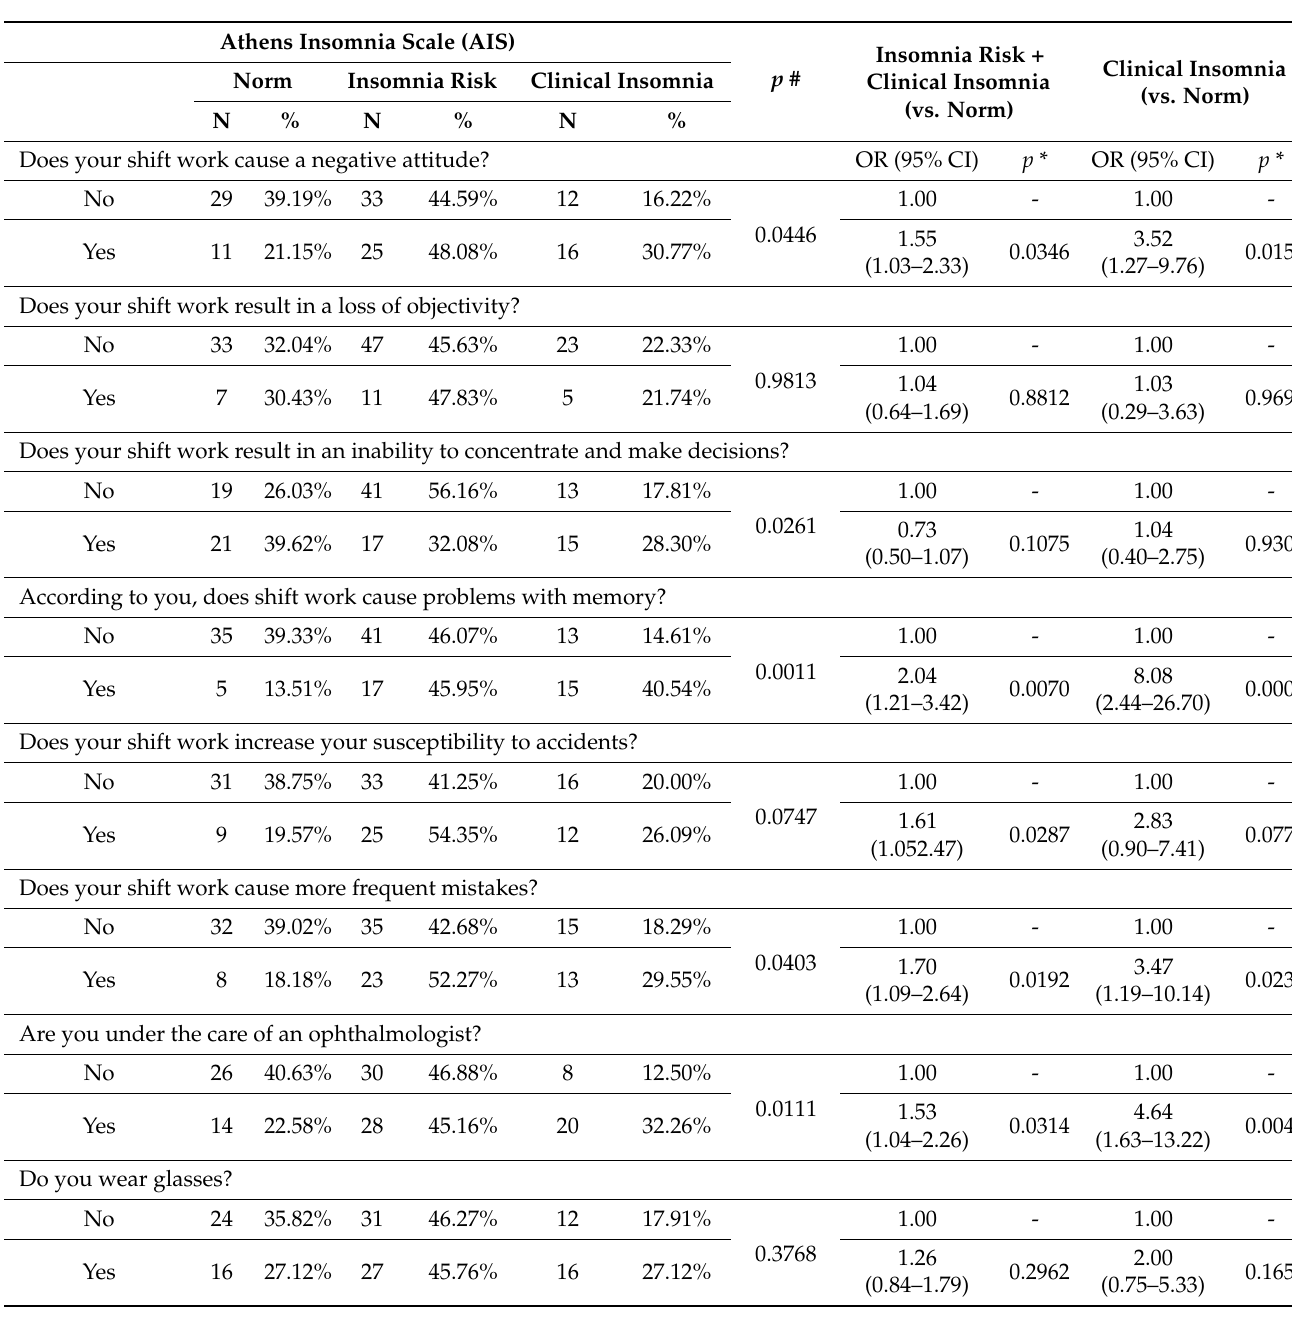
Table 12. Body functioning disorders and sleep disorders in